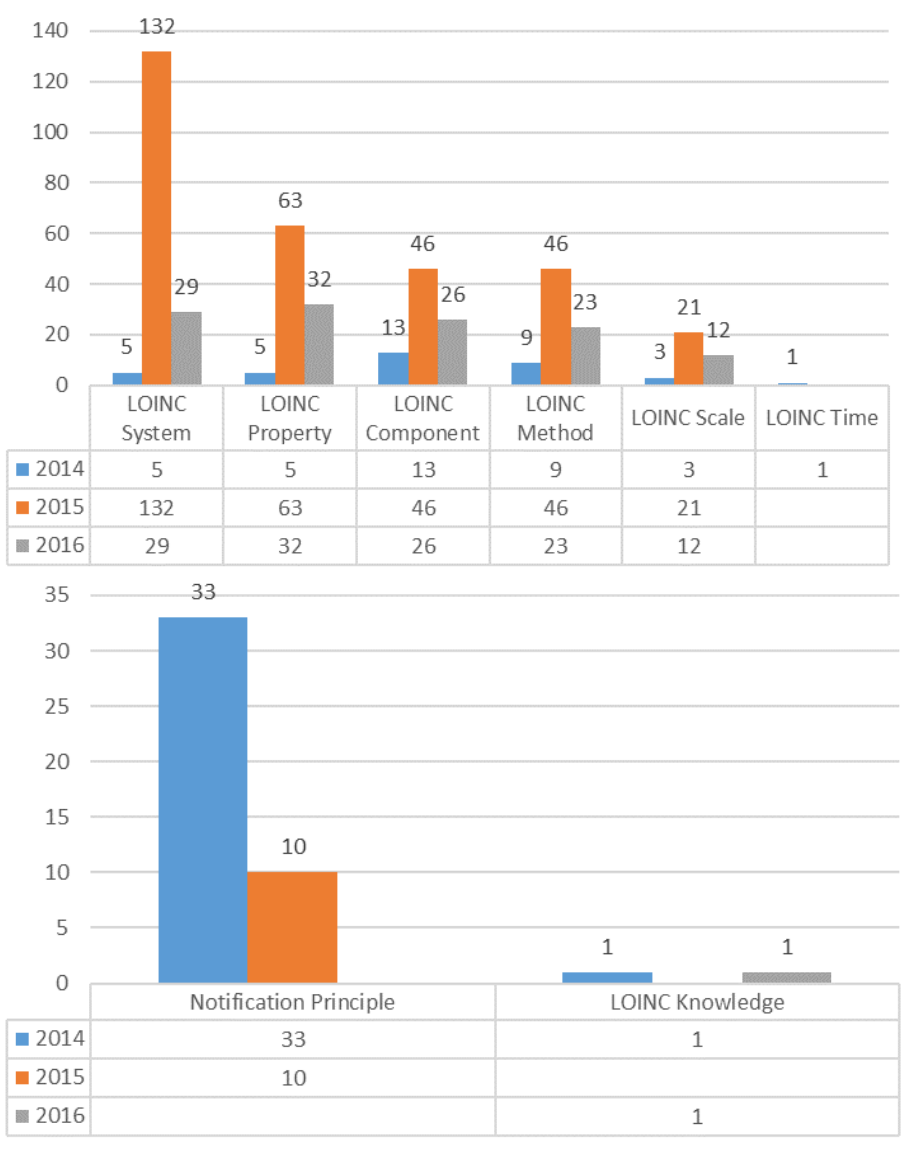
Table 4. Suggestions for LOINC mapping problems.